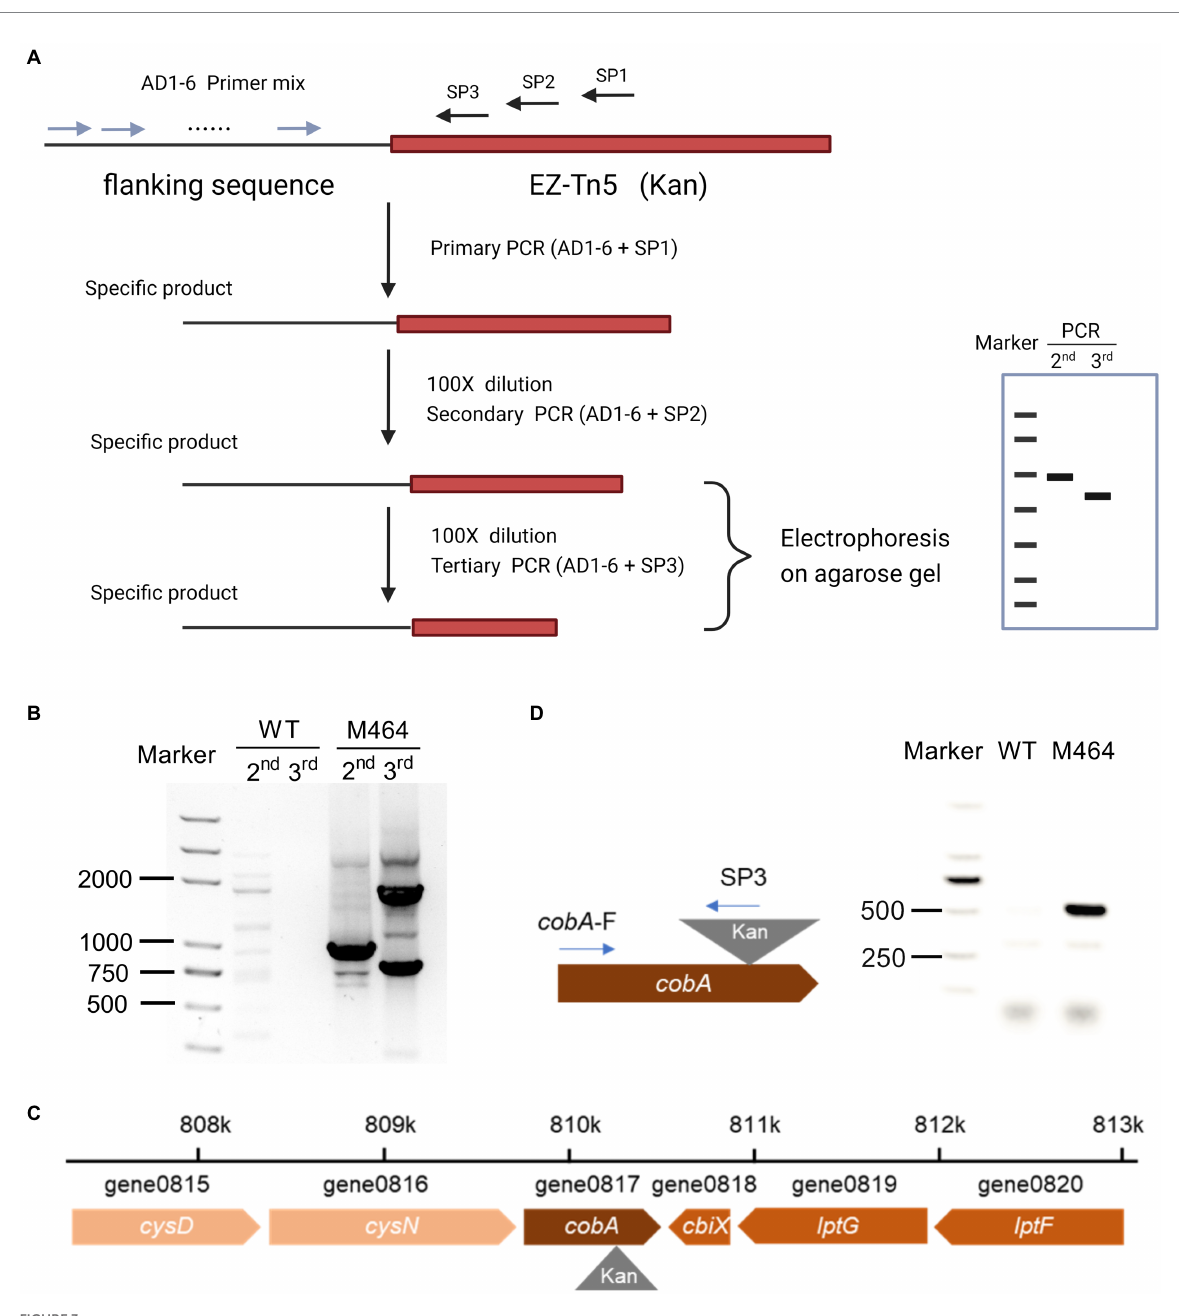
FIGURE 3 The cobA gene was mutated in M464 mutant of Burkholderia arboris . (A) Diagram of thermal asymmetric interlaced PCR (TAIL-PCR). (B) Gel image of TAIL-PCR products. The second and third round of PCR products from wild type (WT) and M464 mutants were run on agarose gel electrophoresis. (C) Diagram of the insertion site of the kanamycin resistance gene ( Kan ) in the M464 mutant. The cobA gene was mutated in the M464 B . arboris mutant. (D) Fragments of PCR products were detected on agarose gel with specific primers from cobA and Kan